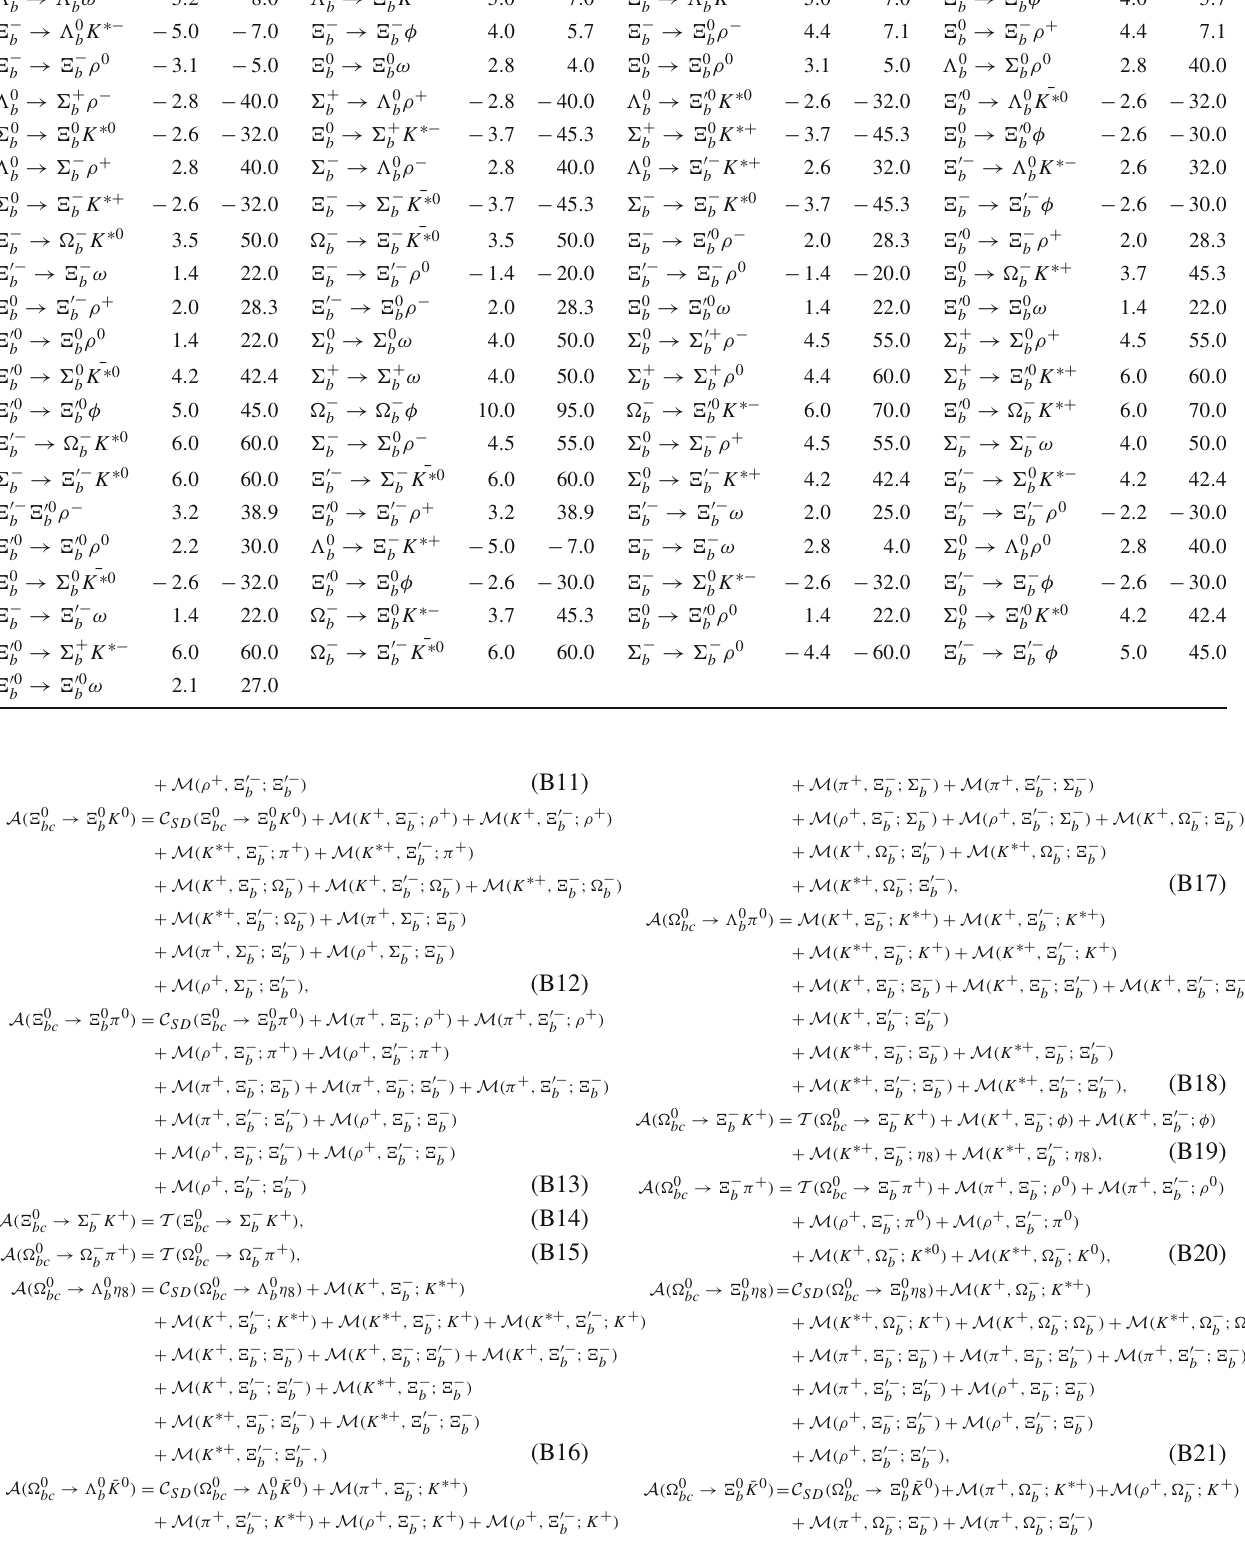
B ¯ B , V B ¯ 6 and V 3 3 3